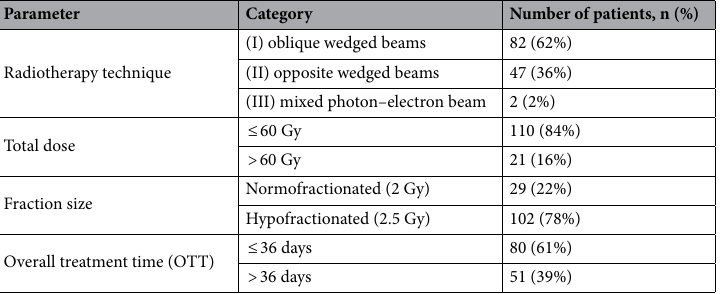
Table 9. Clinical data distribution with regard to irradiation parameters in T1 glottic cancer patients aged 70 and